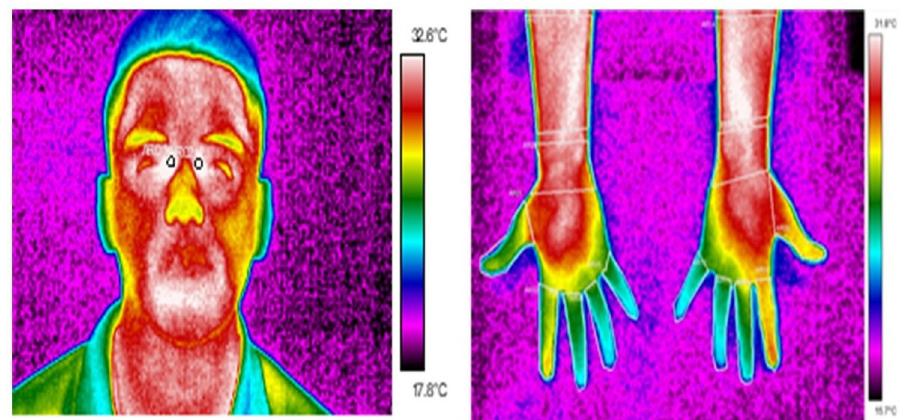
Fig 2. Thermogram of face and palm of the hand with their respective region of interest. The ROIs for face were the carotids, which are found in the tear duct of the eye and ROIs for hands were each region delimited by fingers. Resolution average was 160 x 120